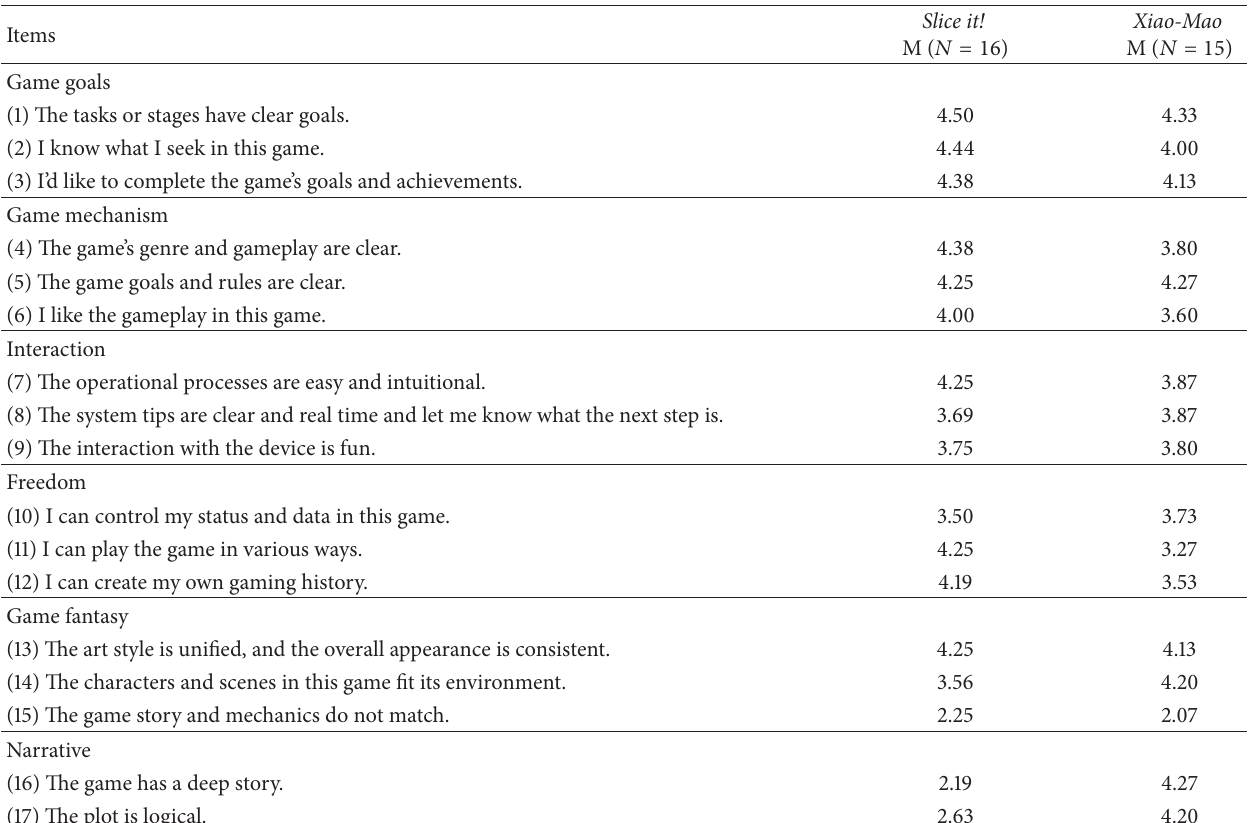
Table 2: Game factor